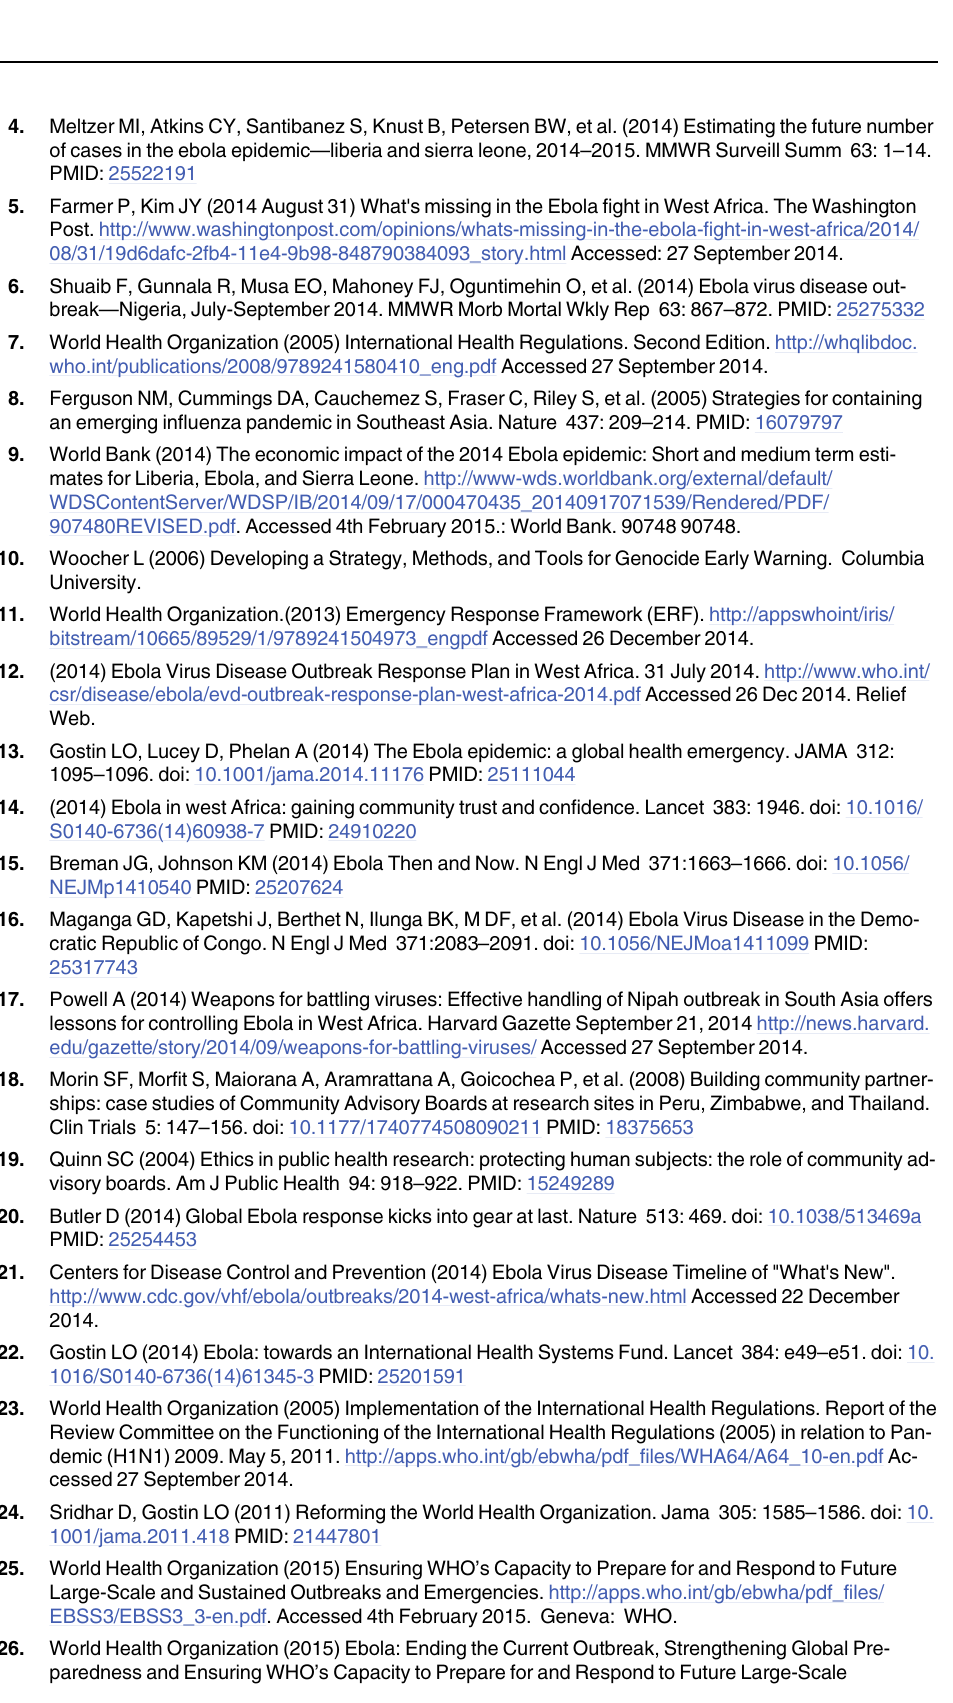
PLOS Medicine | DOI:10.1371/journal.pmed.1001804 March 24,